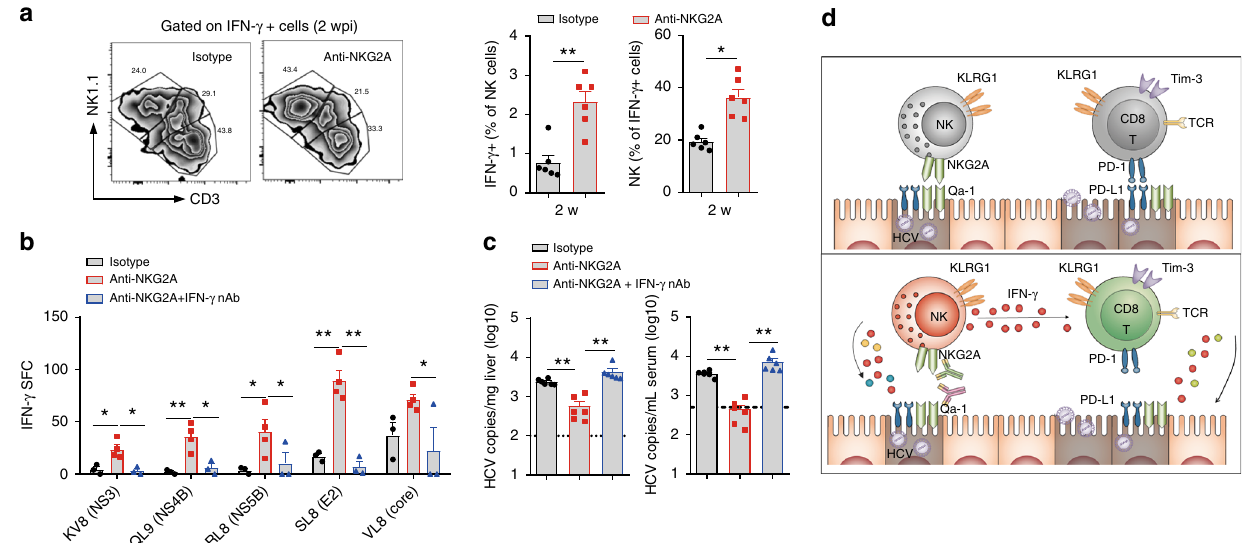
Fig. 7 Anti-NKG2A restored T cell response through enhanced IFN- γ production. a FACS analysis of hepatic IFN- γ positive cells with or without NKG2A blockade 2 wpi. b , c C/O Tg mice ( n = 6 each group) were i.p. pre-treated with IFN- γ neutralization antibody or isotype IgG (100 μ g/3 days) together with anti-NKG2A antibody 1 d before HCV inoculation. b HCV-speci fi c CD8 + T cell response by IFN- γ ELISpot and c serum and hepatic HCV RNA copies